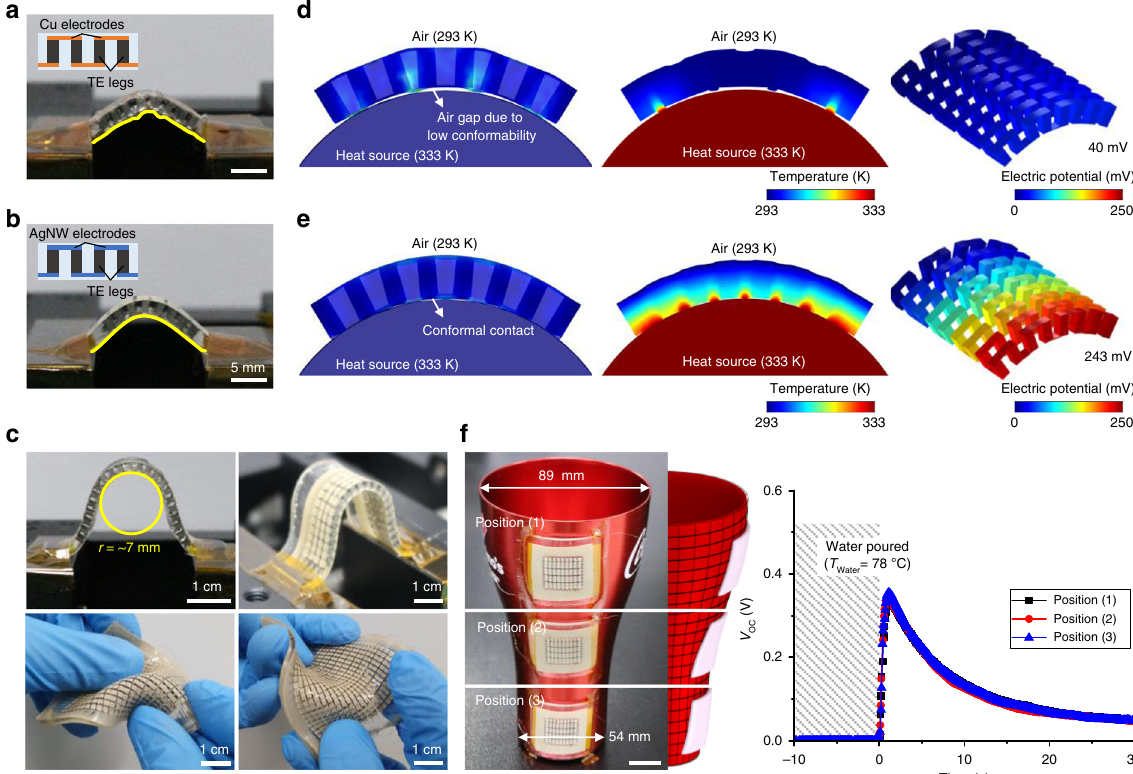
Fig. 5 Mechanical conformability of the compliant TEG. a , b Photographs of bent TEGs comprising Bi 2 Te 3 legs and Cu electrodes ( a ) and AgNW-based soft electrodes ( b ). The each inset shows schematic illustration of side view of each TEG, respectively. Scale bars, 5 mm. c Photographs of the compliant TEGs showing excellent conformability under various deformations. Scale bars, 1 cm. d , e FEA results showing different deformation and heat transfer behaviors corresponding to TE performance for the TEG with Cu electrodes ( d ) and AgNW-based soft electrodes ( e ). f Photographs of a TEG attached to different positions (top, middle, and bottom side) of a bell-shaped aluminum cup. The TEG established conformal contact with the three-dimensional (3D) surface of the aluminum cup. The middle schematic image shows the anisotropic bending curvatures of each position at which the TEG was attached. The right graph shows the time-resolved V OC of the TEG attached to the three positions when hot water is poured into the aluminum cup. Scale bar, 2